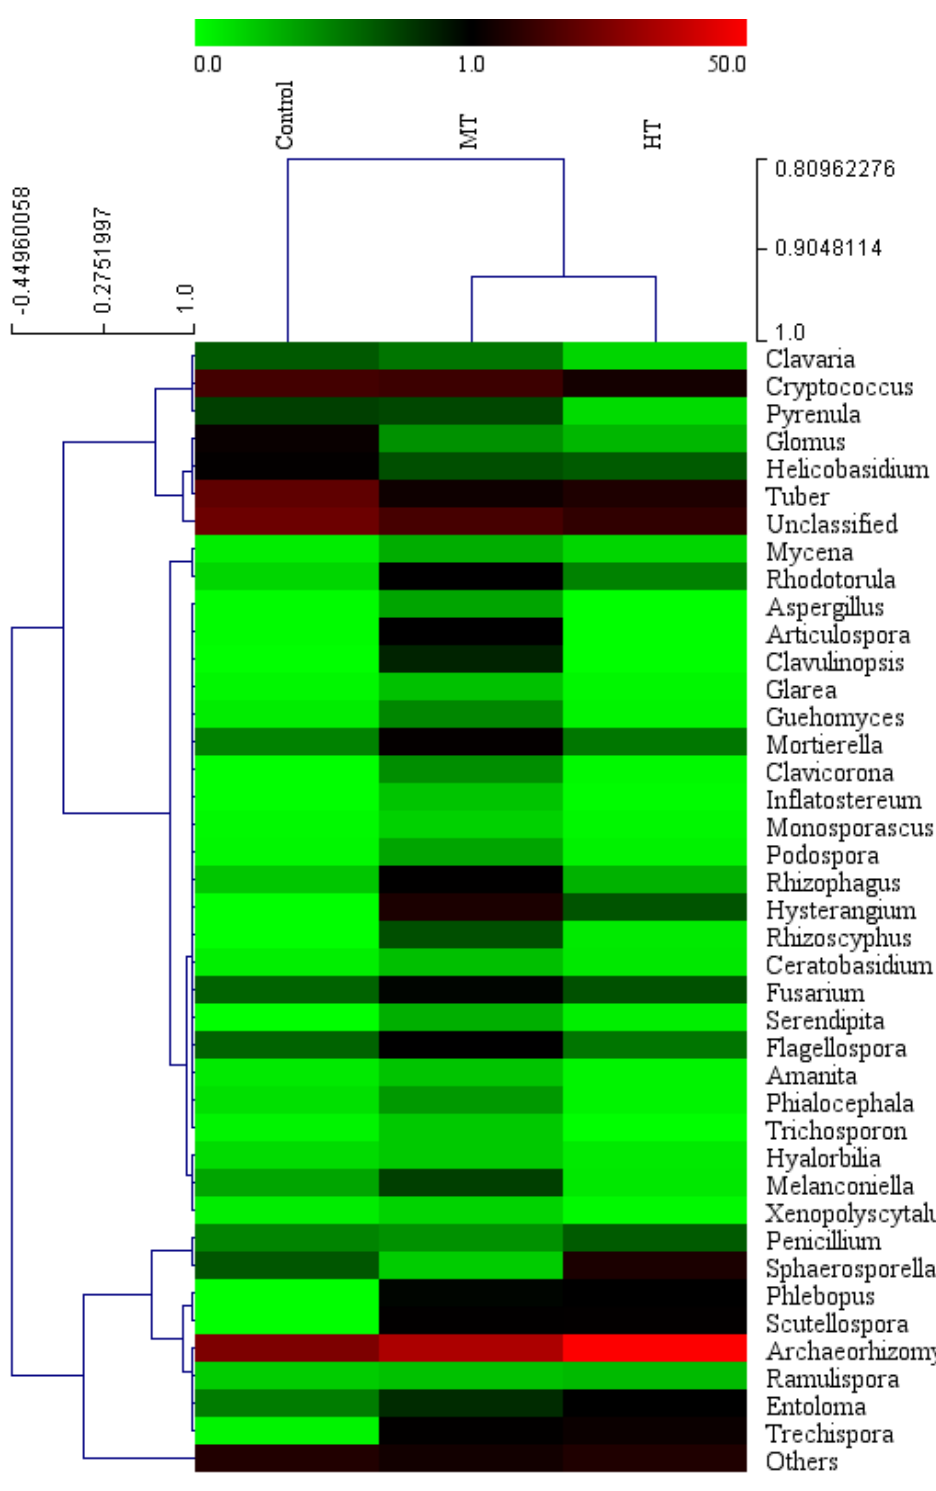
Figure A2. Hierarchically clustered heat-map analysis of the fungal communities (top 40) at the genus level. Control: conventional management model, MT = moderate thinning, and HT = heavy thinning, n = 3.